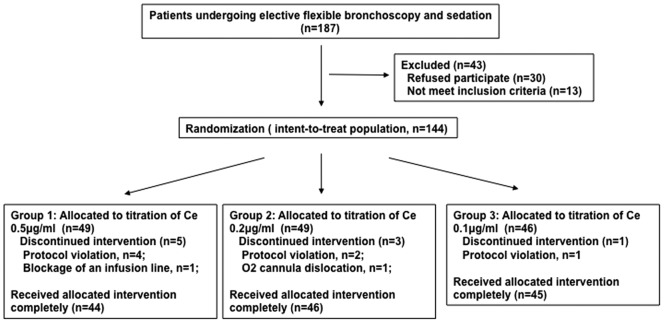
Patient disposition.